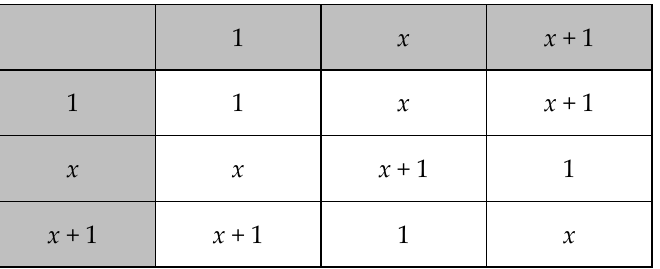
Table 6. The Cayley table of the multiplicative group of the field GF [2 2 ] and of its augmented hyperfield [ GF [2 2 ]].